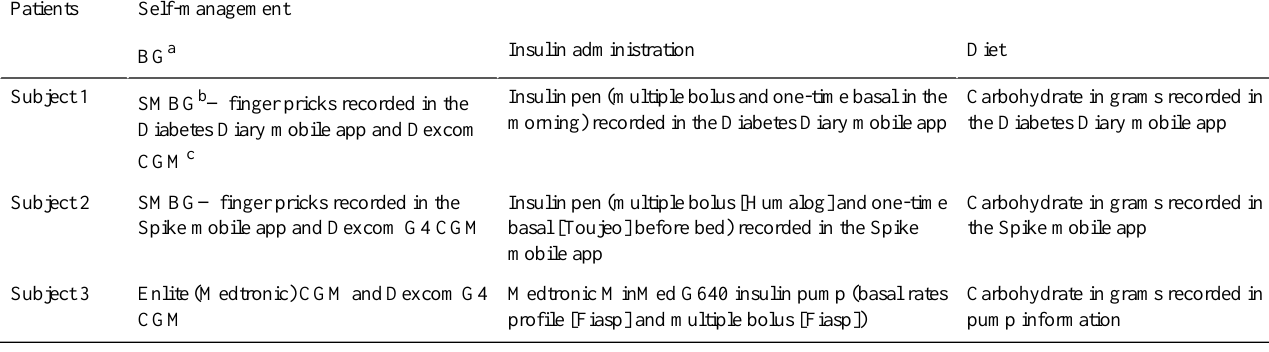
Table 1. Equipment used in diabetes